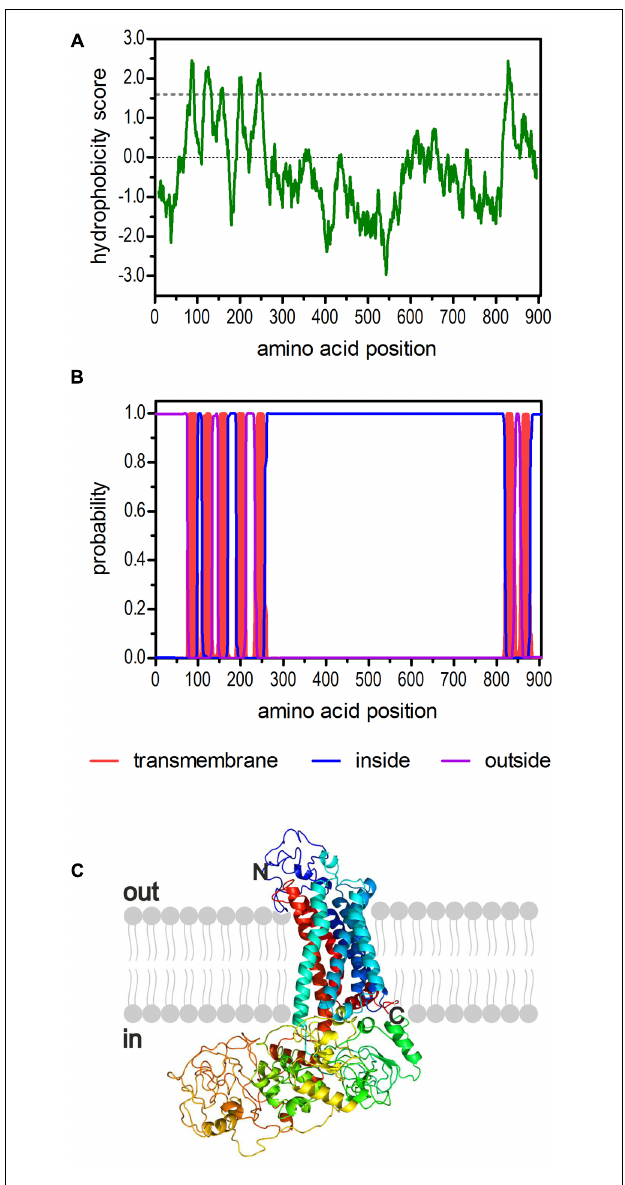
FIGURE 1 | Structural characteristics of the deduced amino acid sequence of Dm5-HT 2B . (A) Hydrophobicity profile of Dm5-HT 2B . The profile was calculated according to the algorithm of Kyte and Doolittle (1982) using a window size of 19 amino acids. Peaks with scores greater than 1.6 (dashed line) indicate possible transmembrane regions. (B) Prediction of transmembrane domains with TMHMM server v. 2.0 (Krogh et al., 2001). Putative transmembrane domains are indicated in red. Extracellular regions are shown as purple line, intracellular regions as blue line. (C) The primary sequence of Dm5-HT 2B was submitted to Phyre2 (Kelley et al., 2015). The 3D model of the receptor is color-coded (rainbow). The extracellular N-terminus and the intracellular C-terminus are